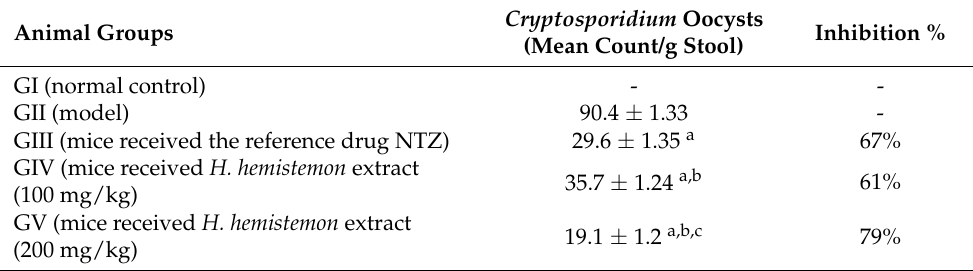
Table 3. Results from Cryptosporidium spp. oocyst in